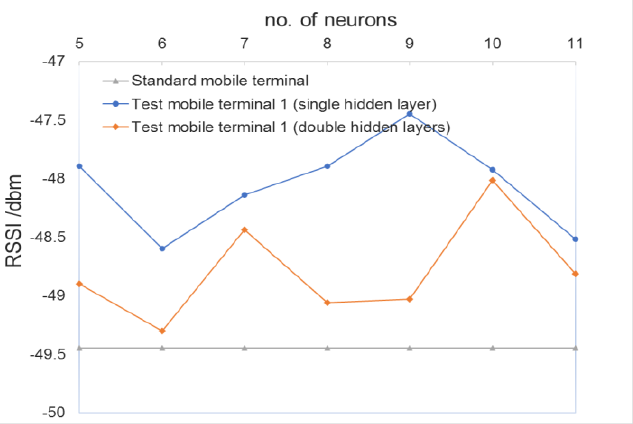
Figure 10. Comparison of the average RSSI value after calibration of test mobile terminal 1.